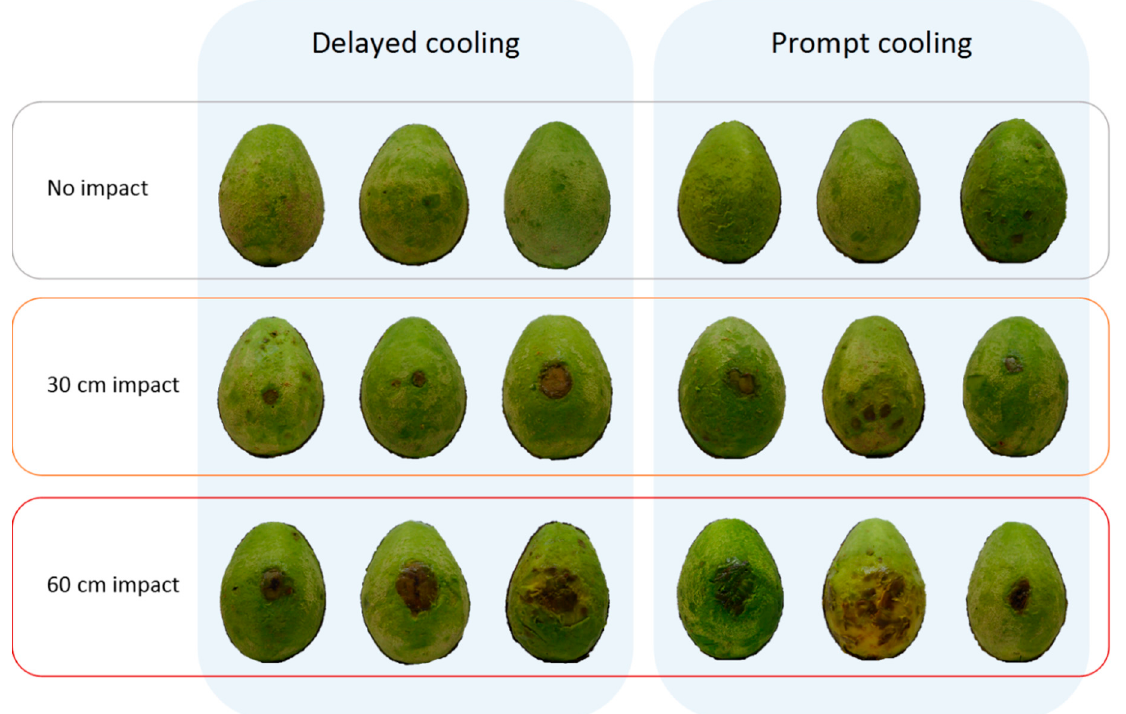
Figure 7. Body rot expression in ‘Hass’ avocado fruit from Experiment 7 at 1 d after reaching firm-ripe stage. Fruit were harvested on 17 and 20 August 2018 and subjected to drop heights of 0, 30 or 60 cm on 21 August 2018. Fruit from the first harvest were held at ambient conditions for 48 h followed by 48 h at 12 °C (delayed cooling). Fruit from the second harvest were cooled to 12 °C on the day of harvest (prompt cooling).